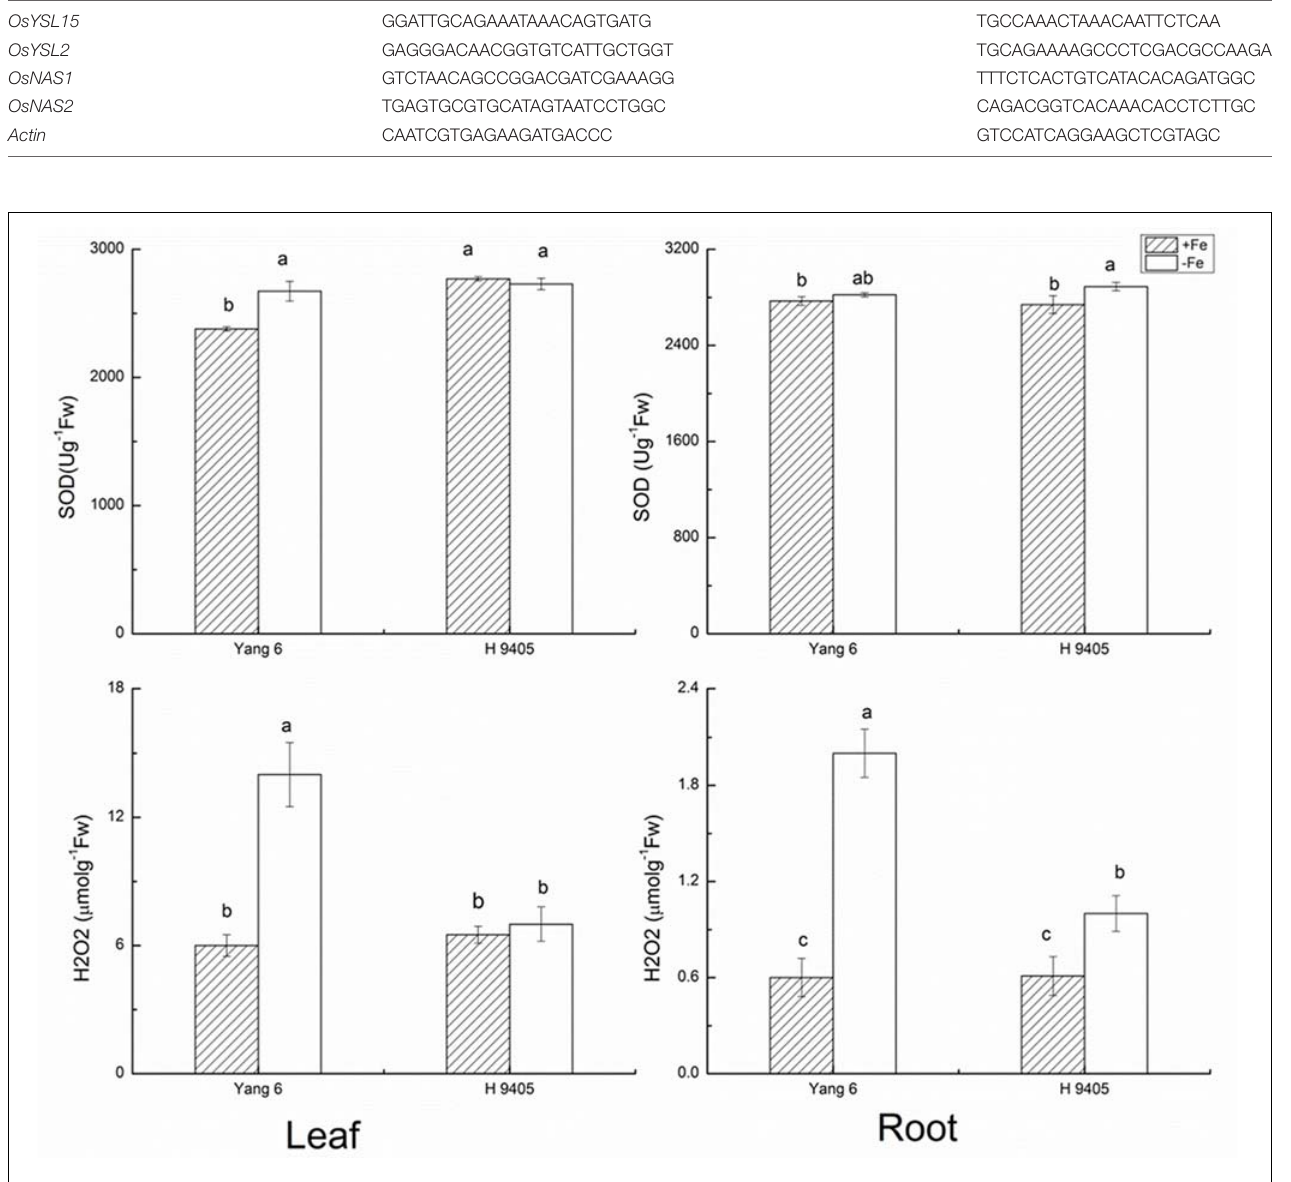
Frontiers in Plant Science |